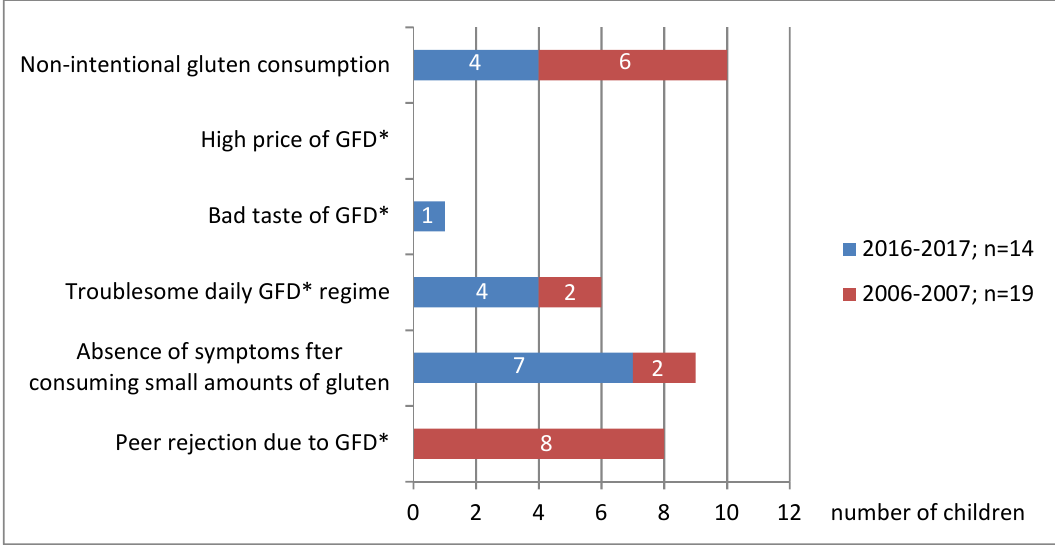
Figure. 4 . Reasons for GFD non-adherence by time of study. * GFD—gluten-free diet. Figure 4. Reasons for GFD non-adherence by time of study. * GFD—gluten-free